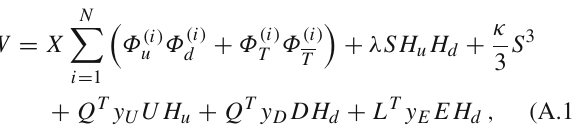
Table 1 we have collected benchmark points representative for the relevant parameter regions and the two